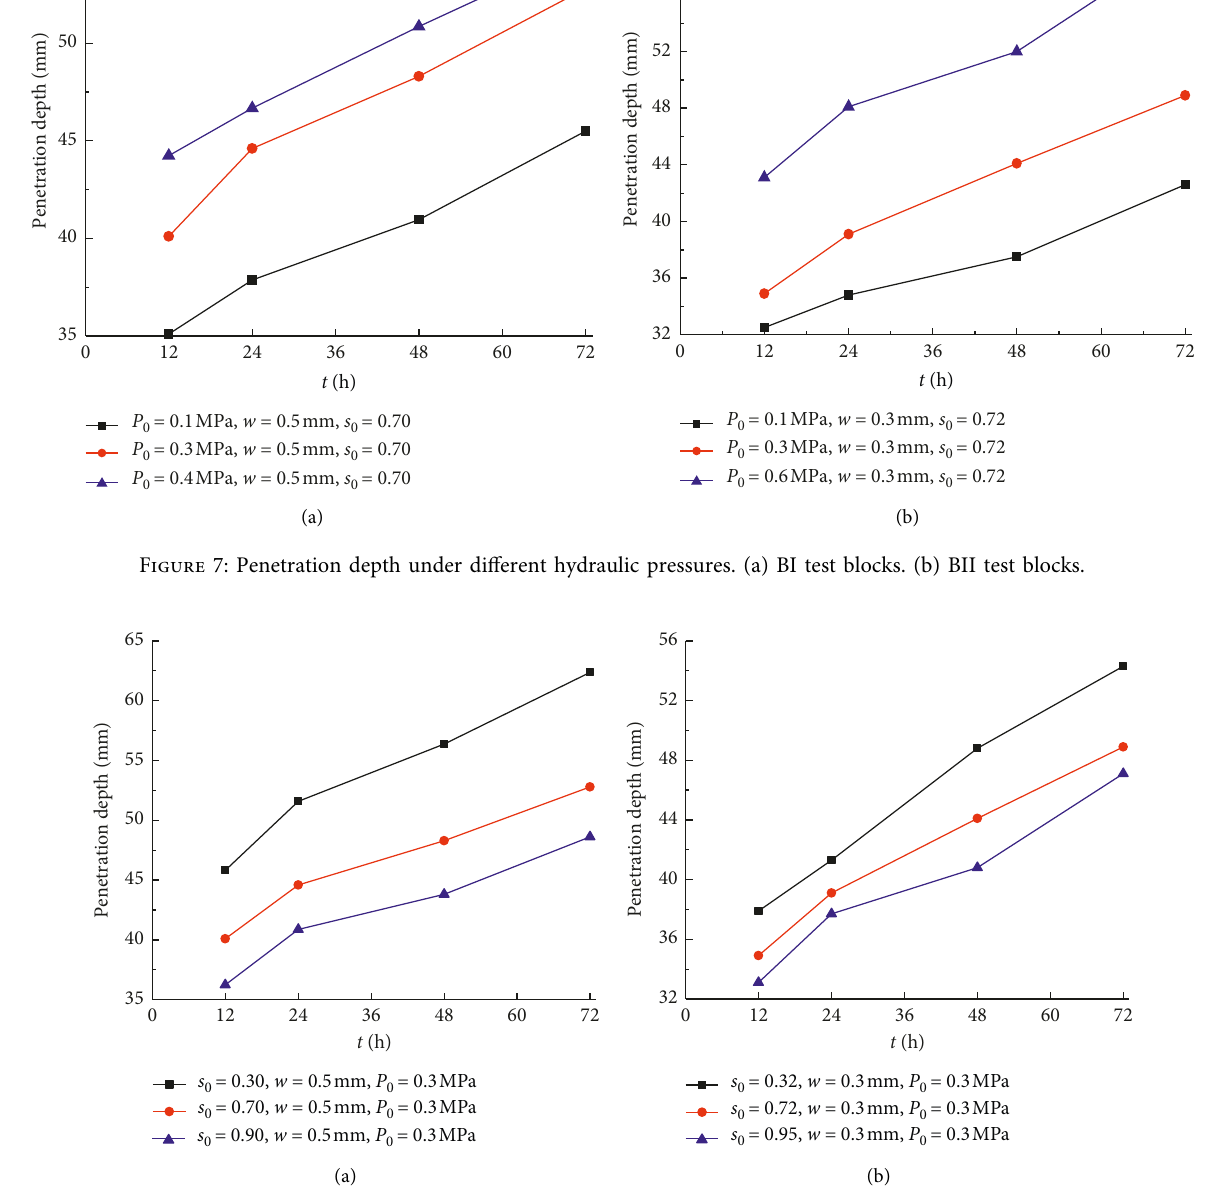
Figure 8: Penetration depth under different initial saturations. (a) BI test blocks. (b) BII test blocks.